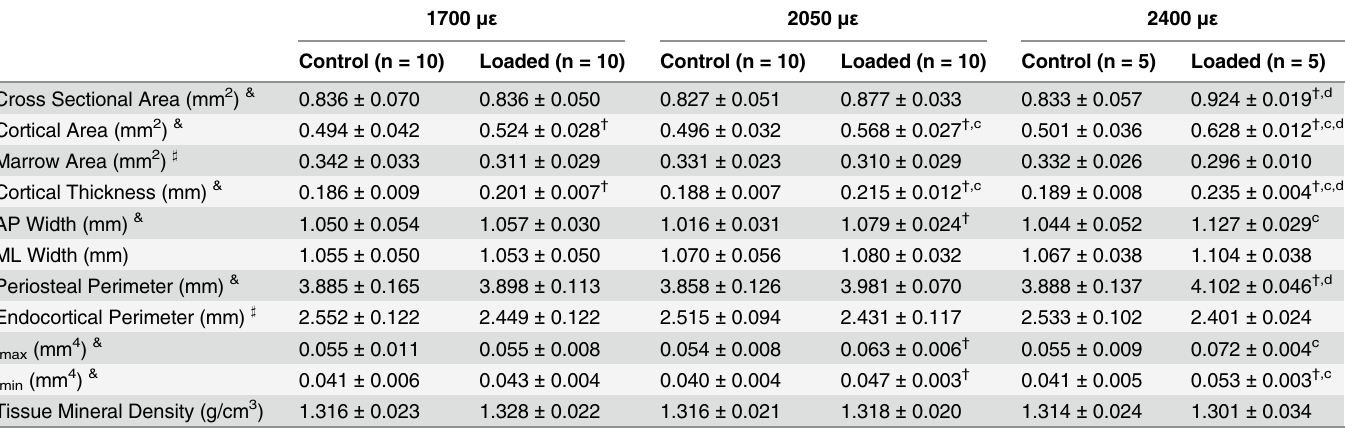
Table 2. Cortical Geometry at the